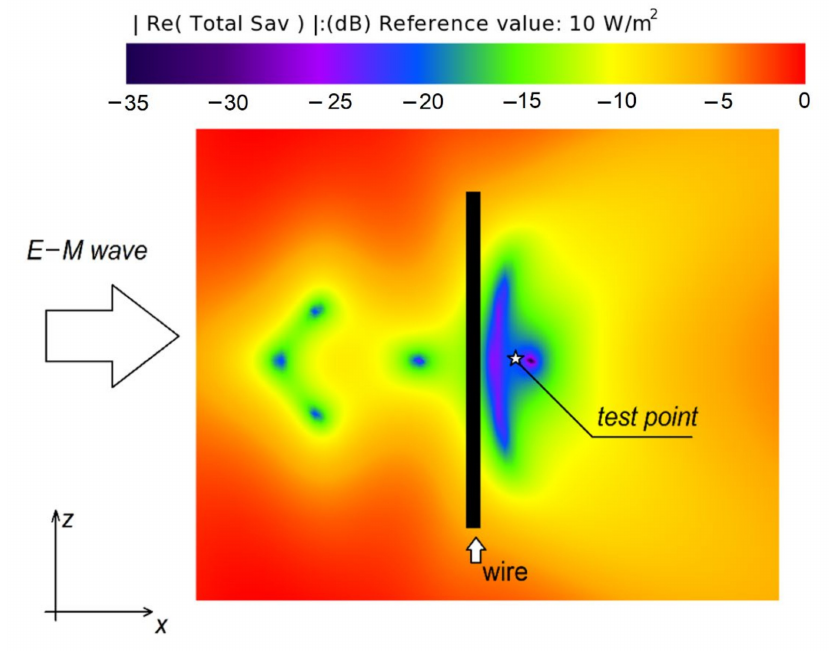
Figure 6. Power density distribution in the x − z ( y = 0) plane for the four wire array (the length of wires: 47 mm, conductivity: 500 S/m). Values given in logarithmic scale with reference value 10 W/m 2